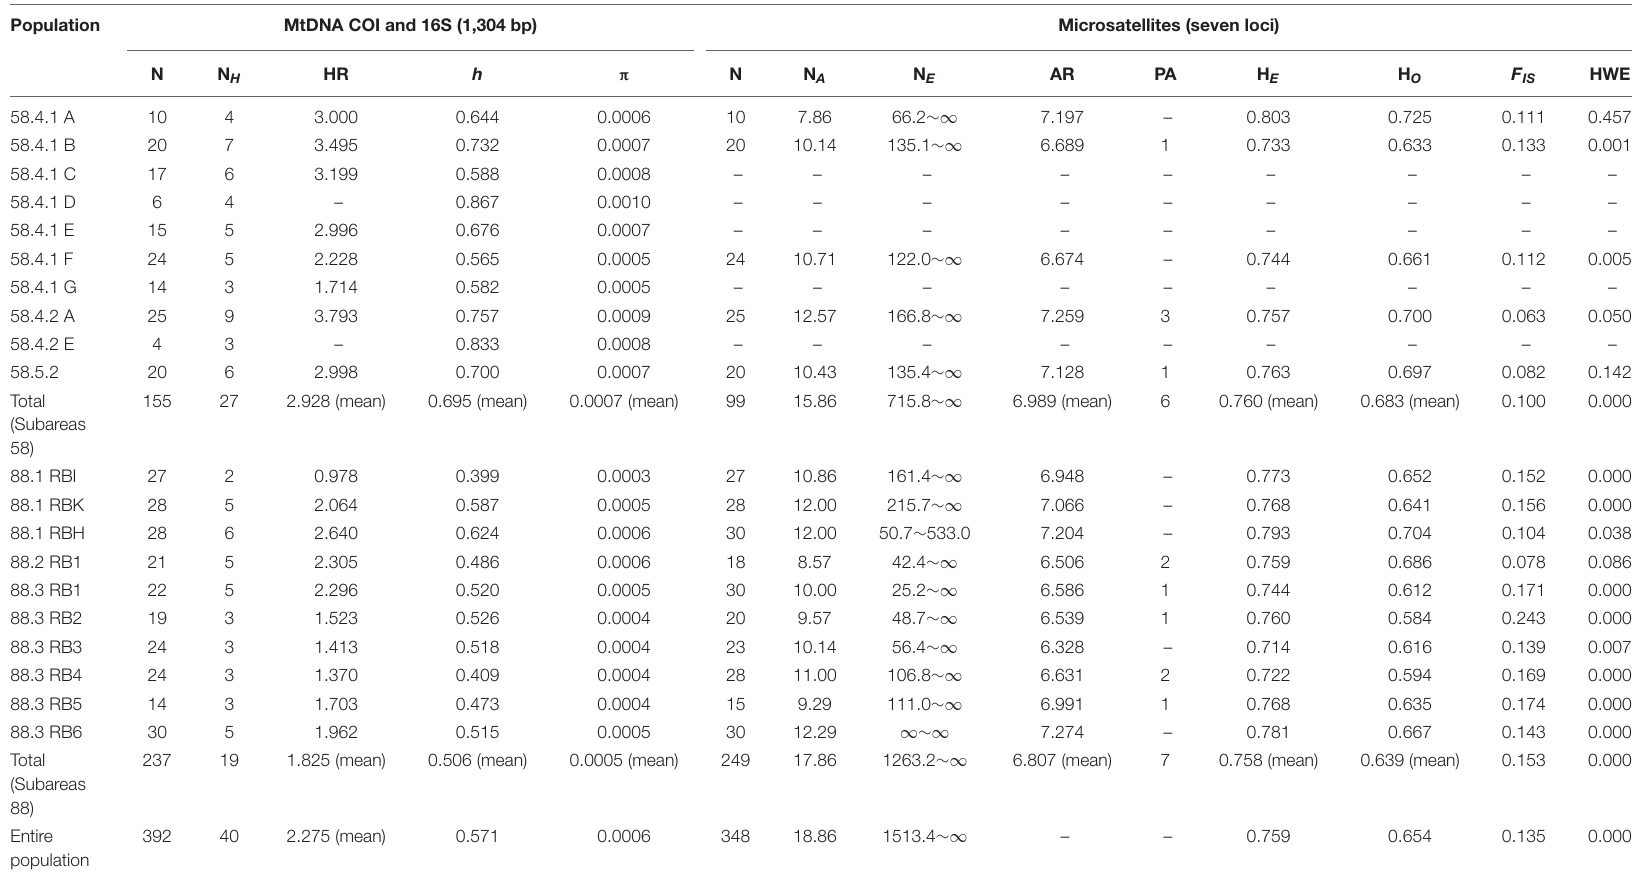
TABLE 1 | Summary of the genetic diversity indices in Dissostichus mawsoni from the Antarctic Ocean at mtDNA (COI and 16S) and seven microsatellite loci. Population MtDNA COI and 16S (1,304